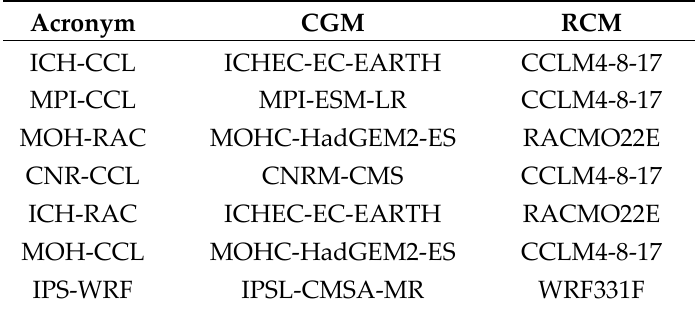
Table 1. Regional Climate Models